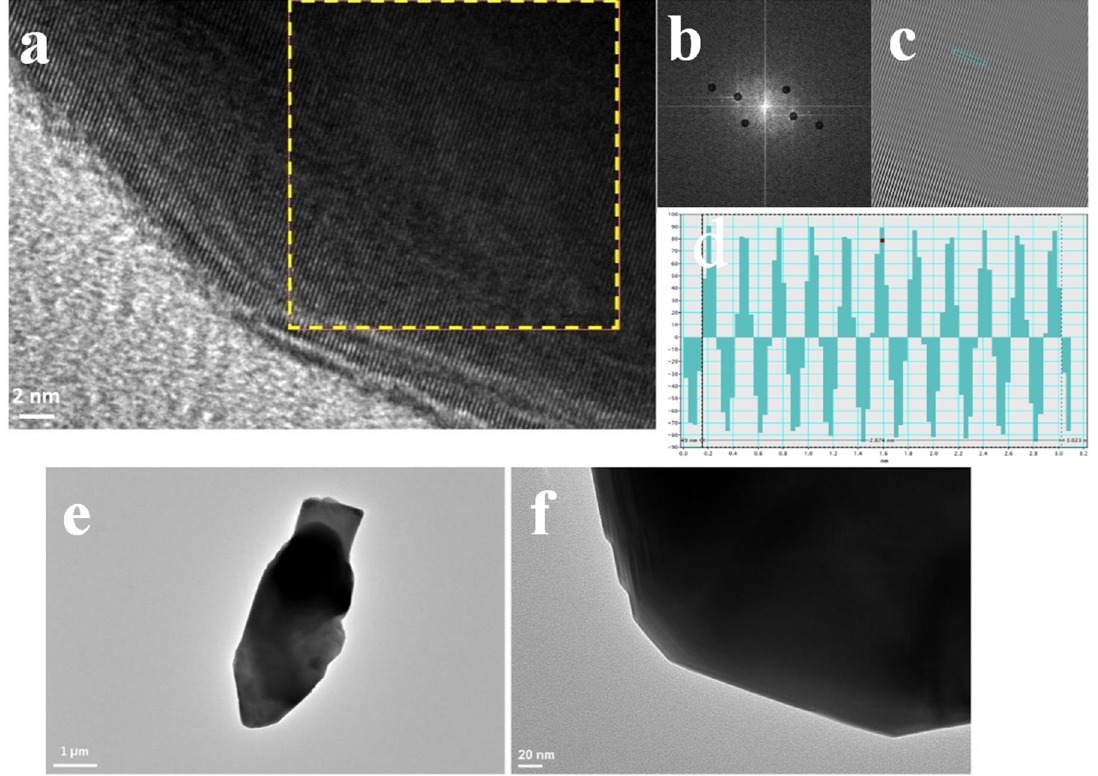
Figure 2. ( a ) HRTEM micrograph of CMAT powders, ( b ) digital SAEDP using a fast Fourier transform (FFT) of the area inside the yellow inset, ( c ) inverse FFT image of the area inside the yellow inset, ( d ) intensity profile–lattice distance analysis along the blue line (based on Gatan Digital Micrograph), and ( e ), ( f ) low-magnification TEM image.